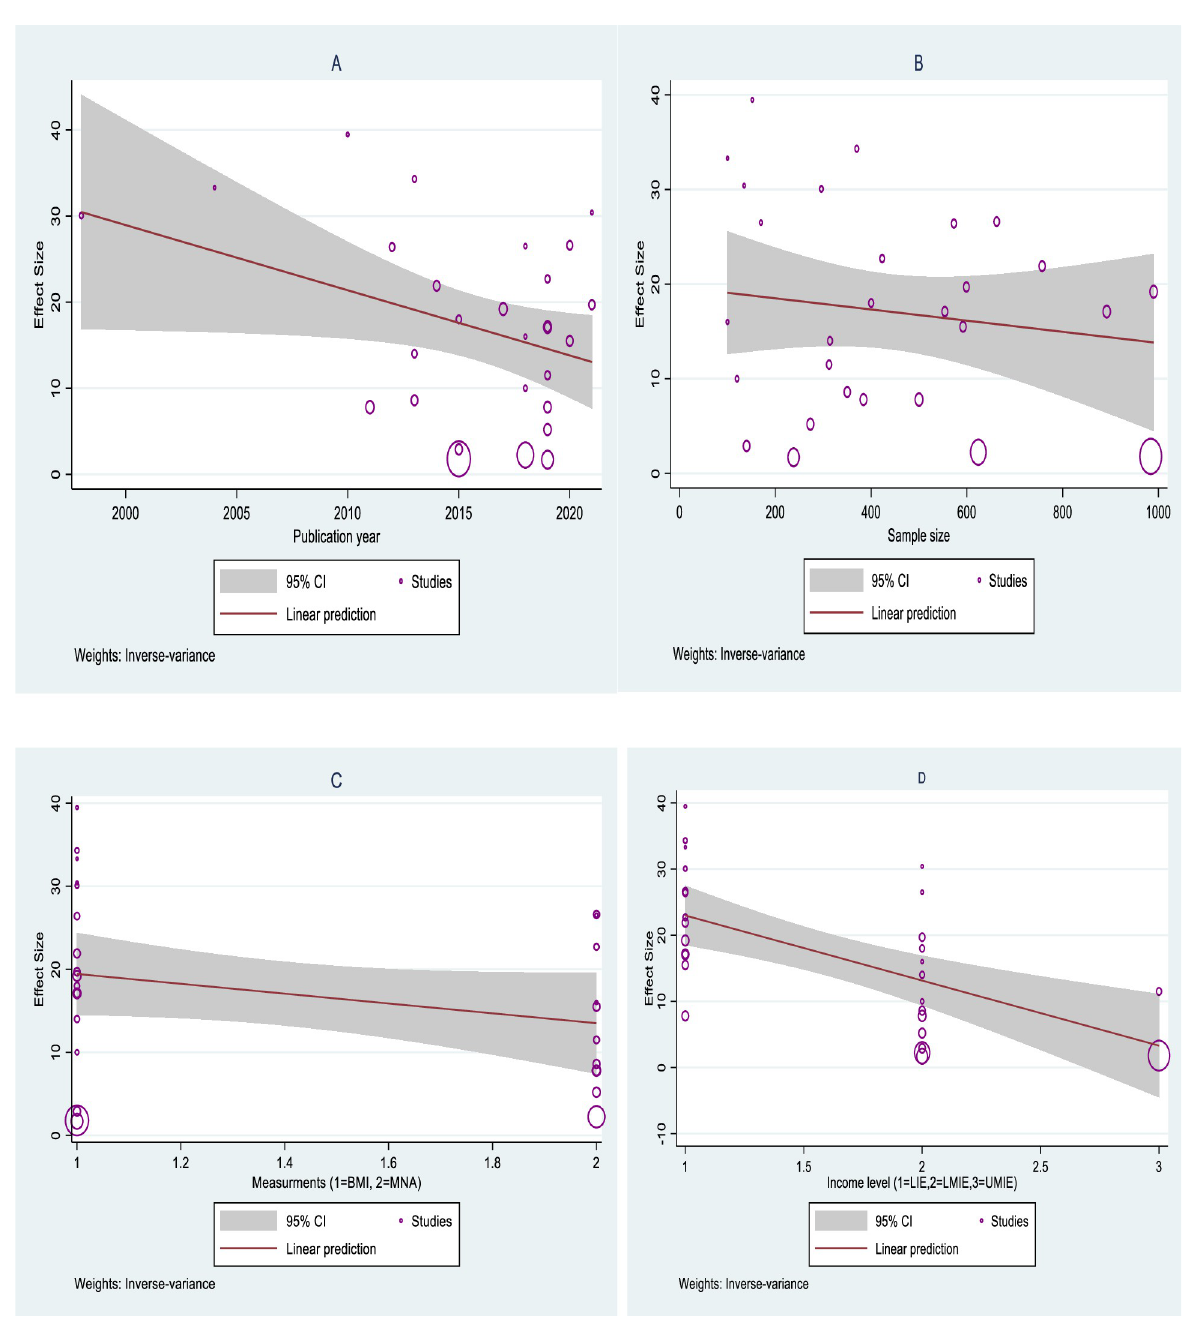
Fig 4. Linear relationship between malnutrition and selected